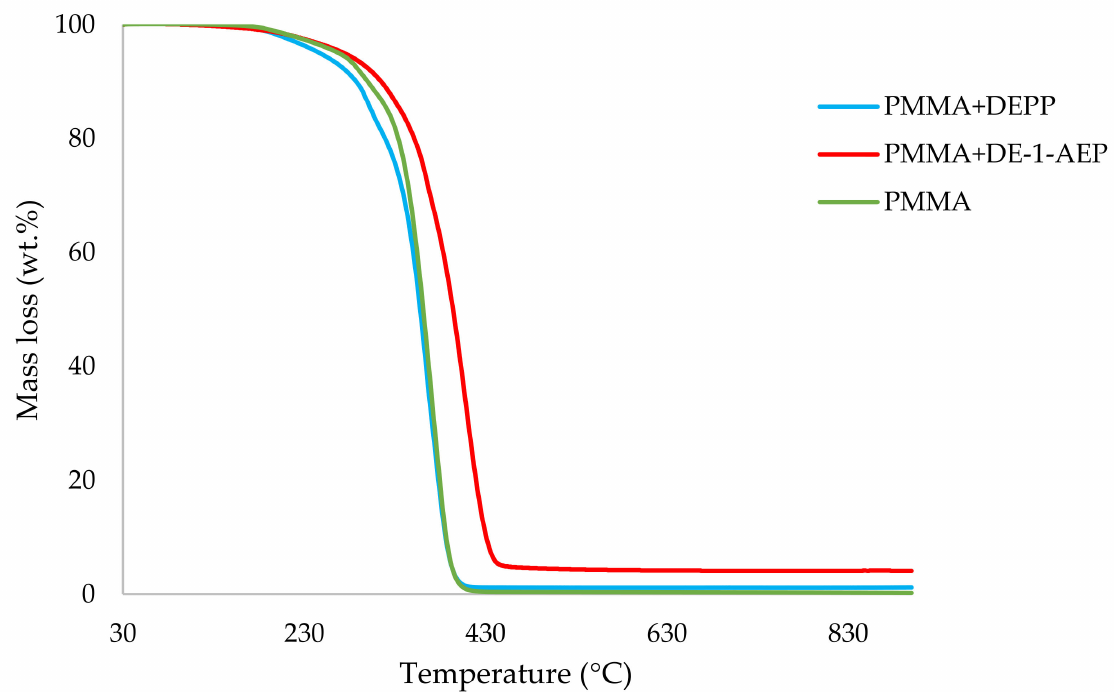
Figure 4. An overlay of the TGA curves of PMMA and PMMA + aliphatic phosphonate